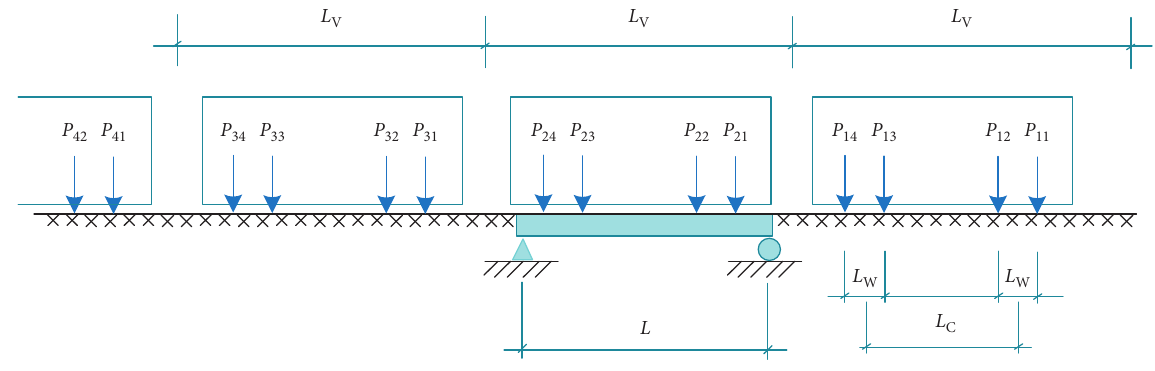
Figure 1: The moving load